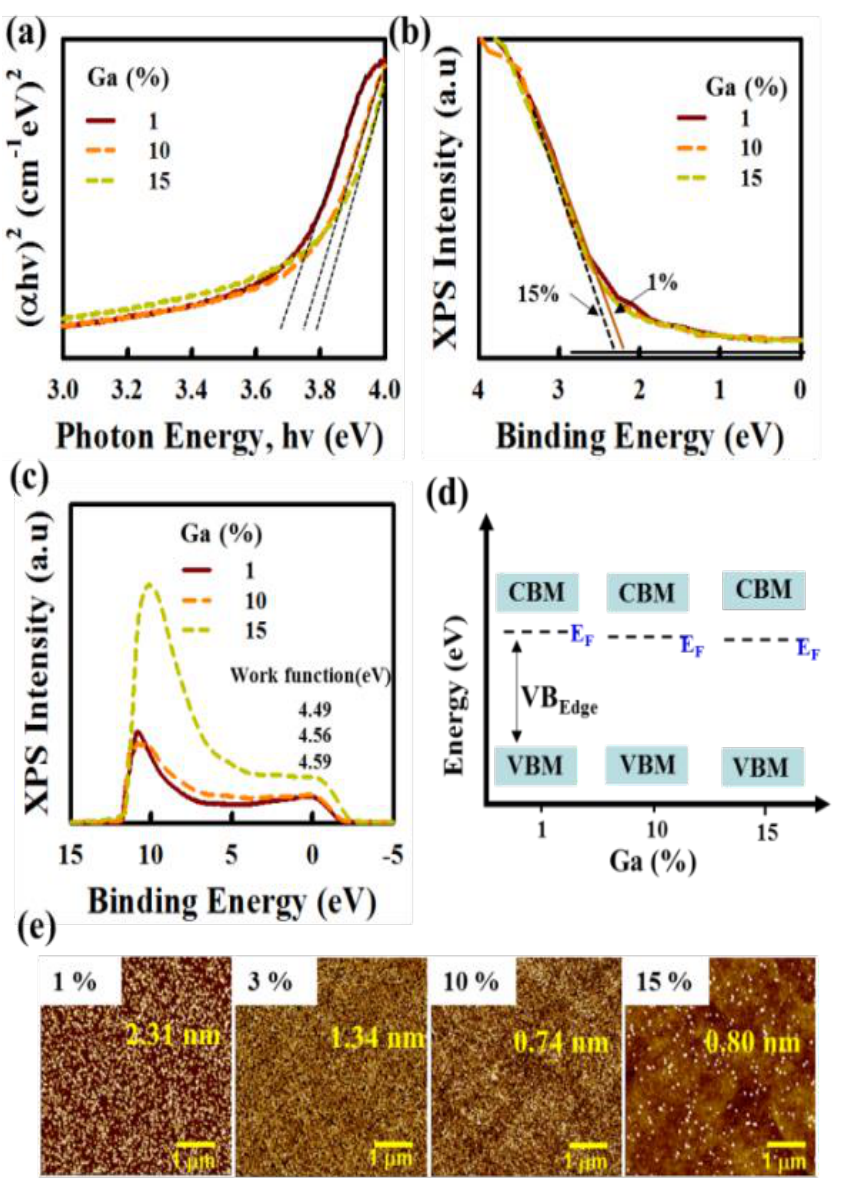
Figure 3. ( a ) Tauc plot and ( b ) XPS valance band edge (VB Edge ) spectra of the IGTO films with different Ga (from 1 to 15%) ratios. ( c ) Ultra-violet photoelectron spectroscopic (UPS) spectra of the IGTO films with different Ga (1, 10, and 15%) ratios. ( d ) Energy level diagram of the IGTO films with the different Ga (from 1 to 15%) ratio. The Fermi energy level (E F ) decreases with increasing Ga ratio. ( e ) AFM images (scan size 5 μ m × 5 μ m) of 1, 3, 10, and 15% Ga-doped IGTO thin films.